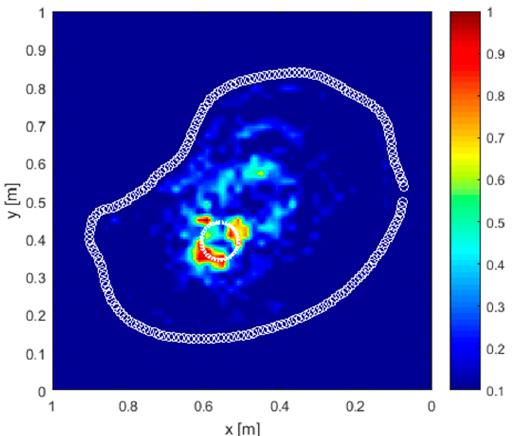
Figure 14. Tomographic reconstruction of the complex-shaped hardwood tree scenario without the application of time-gating. The dashed white circle indicates the actual position of the anomaly. The circles in white solid line along the trunk perimeter represent the positions of the measurement points.